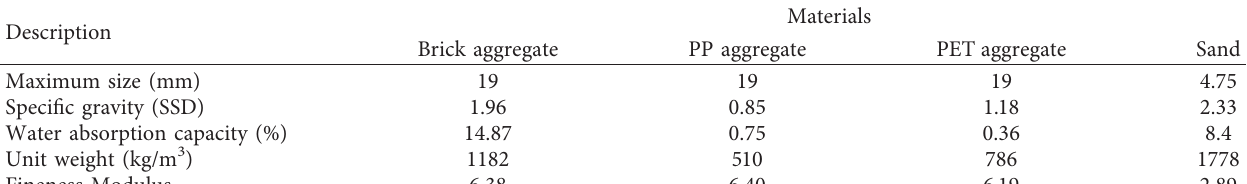
Table 2: Properties of both coarse and fine aggregates.